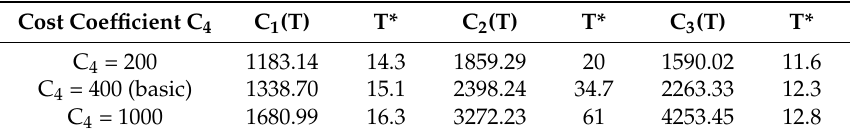
Table 11. Optimal release time T* according to cost coefficient C